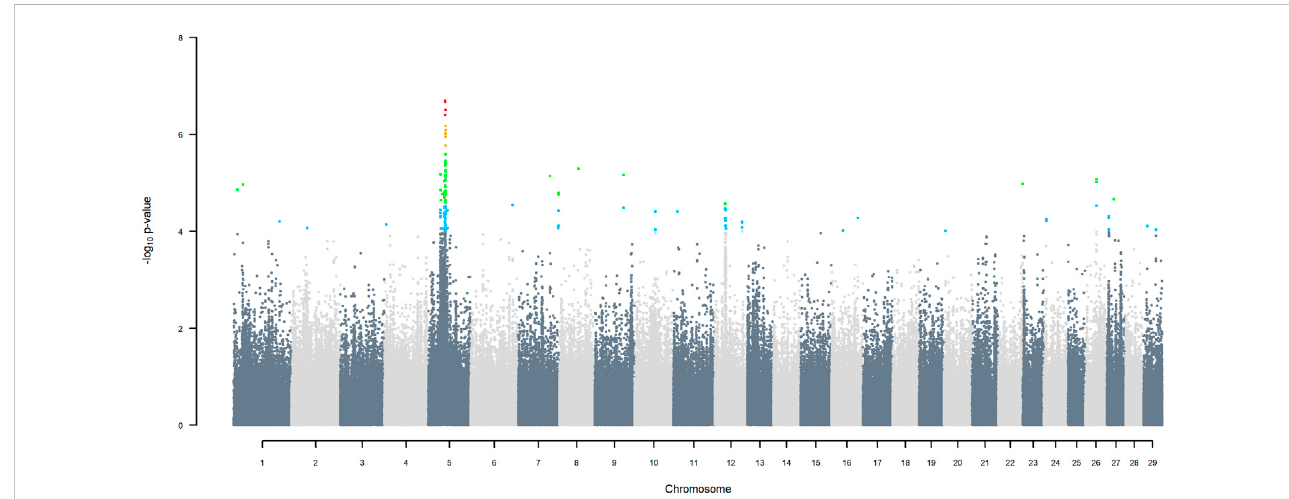
FIGURE 7 Manhattan plot of GWAS (Model 4) for indigenous versus Jersey origin using SNP alleles of all origins that had a MAF > 1%. SNP that passed the FDR threshold of 5%, 10%, 20%, and 30% are highlighted in red, orange, green, and blue, respectively.